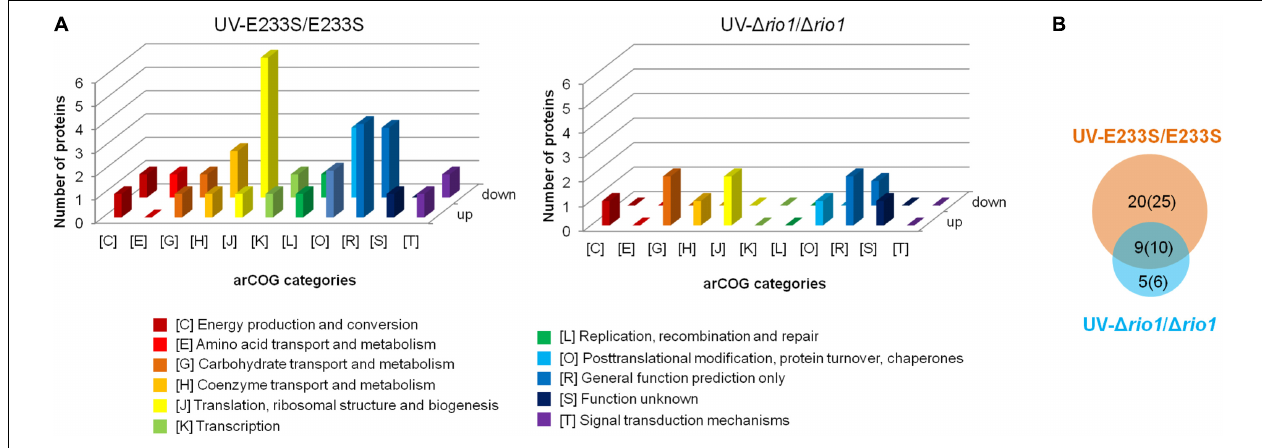
FIGURE 4 | Analysis of differentially phosphorylated proteins in a comparison of UV-treated E233S versus E233S and UV-treated (cid:49) rio1 versus (cid:49) rio1 . (A) COG analysis of differentially phosphorylated proteins in UV-treated E233S versus E233S (left panel) and UV-treated (cid:49) rio1 versus (cid:49) rio1 (right panel). Both increased (up) and decreased (down) phosphorylated proteins are shown. The categories of arCOG are indicated at the bottom. (B) Overlap analysis of the numbers of differentially phosphorylated proteins (sites) between UV-treated E233S versus E233S (orange) and UV-treated (cid:49) rio1 versus (cid:49) rio1 (cyan). The numbers in brackets are those of phosphorylated